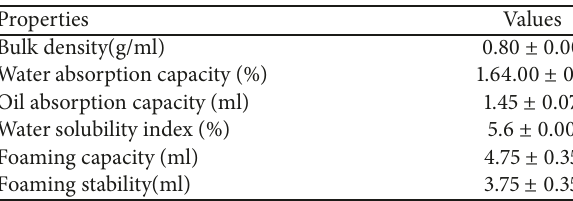
Table 4: Functional properties of cactus pear seed